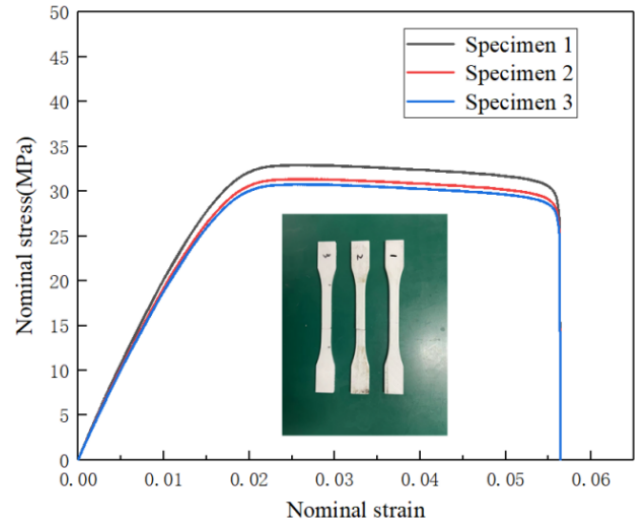
Figure 7. The nominal stress-strain curves of the PLA material.